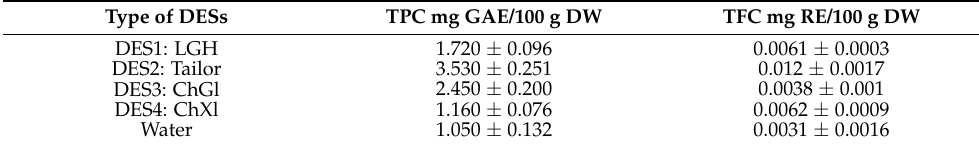
Table 4. Phytochemical contents of Rosmarinus officinalis extracts.